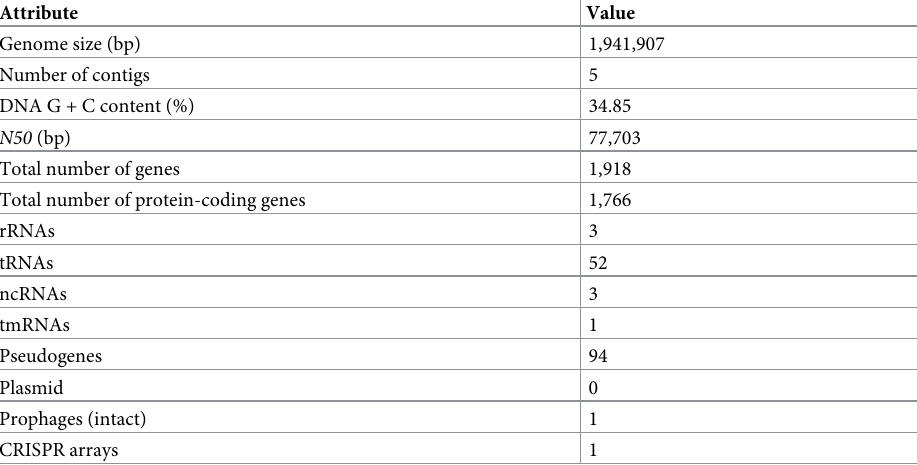
Table 2. General genome features of Lactobacillus paragasseri